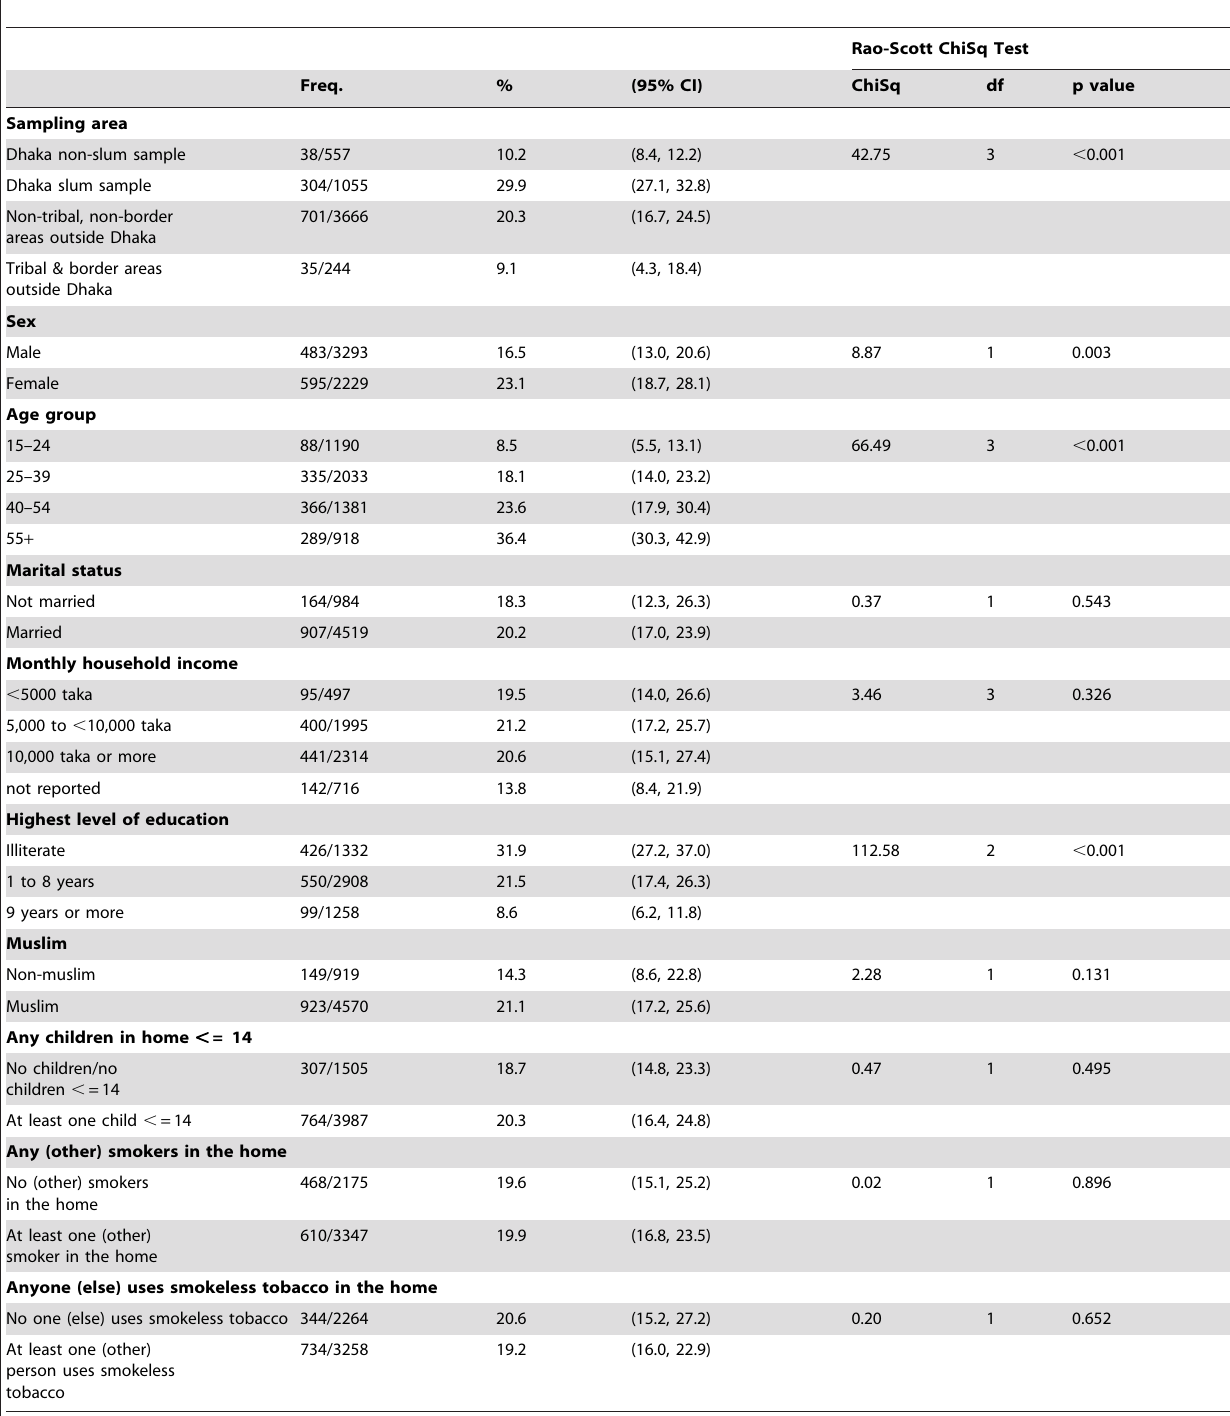
Table 2. Smokeless tobacco use by demographic characteristics among Bangladeshi residents (weighted), Bangladesh 2011.